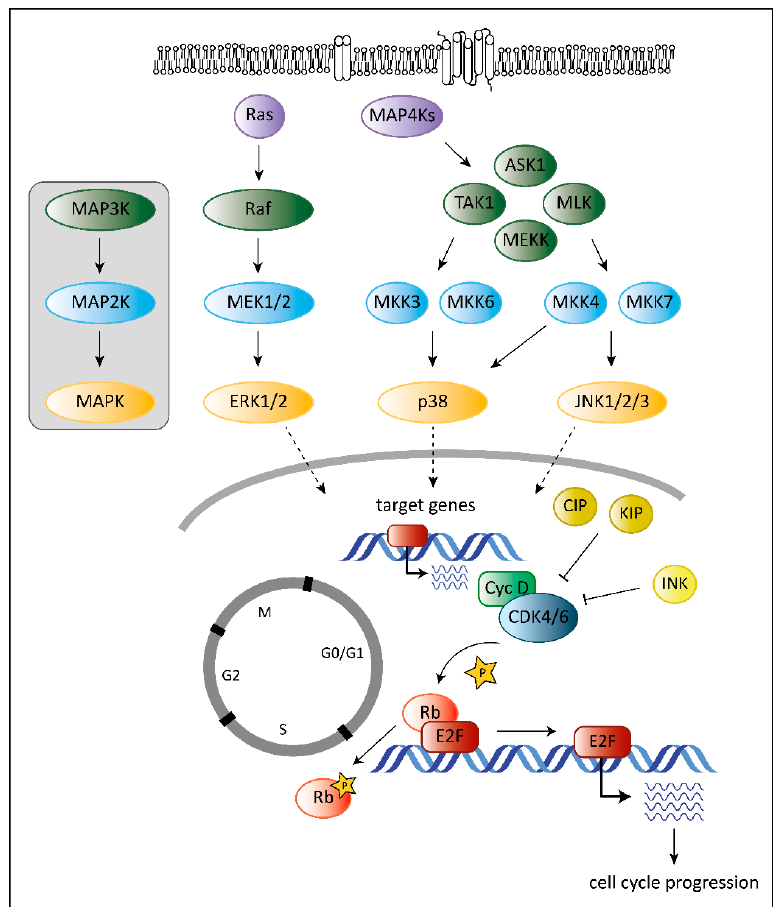
Figure 1. Overview of the best-studied MAPK signaling cascades and their interplay with the cell cycle machinery. MAPK cascades consist of three core kinases. The general pattern of the core kinases is shown in the box on the left. The three core kinases are activated by upstream kinases (MAP4Ks, Ras). Activation is indicated by the arrows. Activated MAPKs translocate into the nucleus (indicated by the dashed arrows) and induce expression of their target genes. Target genes of MAPKs are among others genes encoding D-type cyclins. They bind and activate cell cycle kinases CDK4 and 6 leading to phosphorylation on Rb (indicated by the star symbol) and to release of Rb-mediated repression of E2F target genes resulting in progression of the cell cycle to the S-phase. Members of the CIP/KIP and the INK protein families inhibit CDK4/6 as indicated by the “T-lines”.